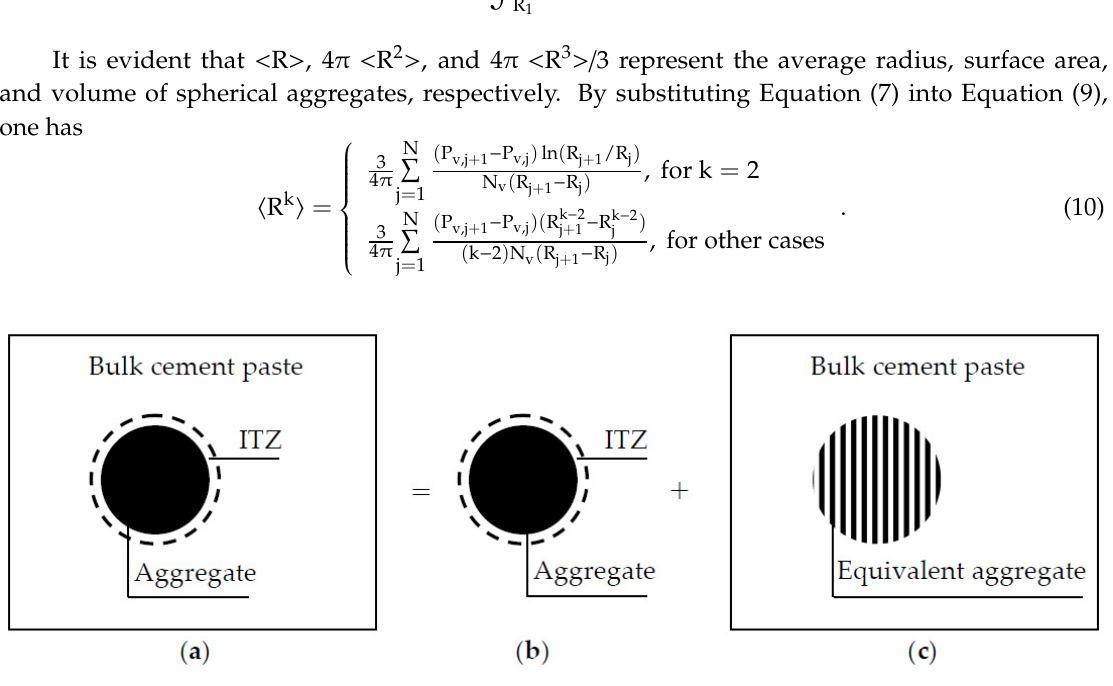
Figure 1. ( a ) Three-phase concrete; ( b ) equivalent aggregate; and ( c ) two-phase concrete.